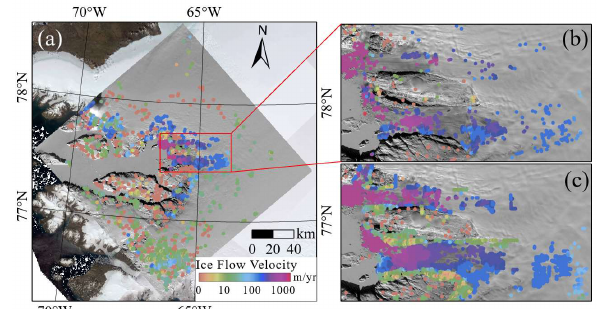
Figure 6 . Matching results of two glaciers in Northwest Greenland using early Landsat images (1973.03-1973.09). (a) Matching results at the image scale, (b)Zoom in of the area where the Tracy and Heilprin glaciers are located, and (c) Matching results at the glacier scale within the red box. The background in (a) is a Landsat Image Mosaic of Greenland (Chen et al., 2020).